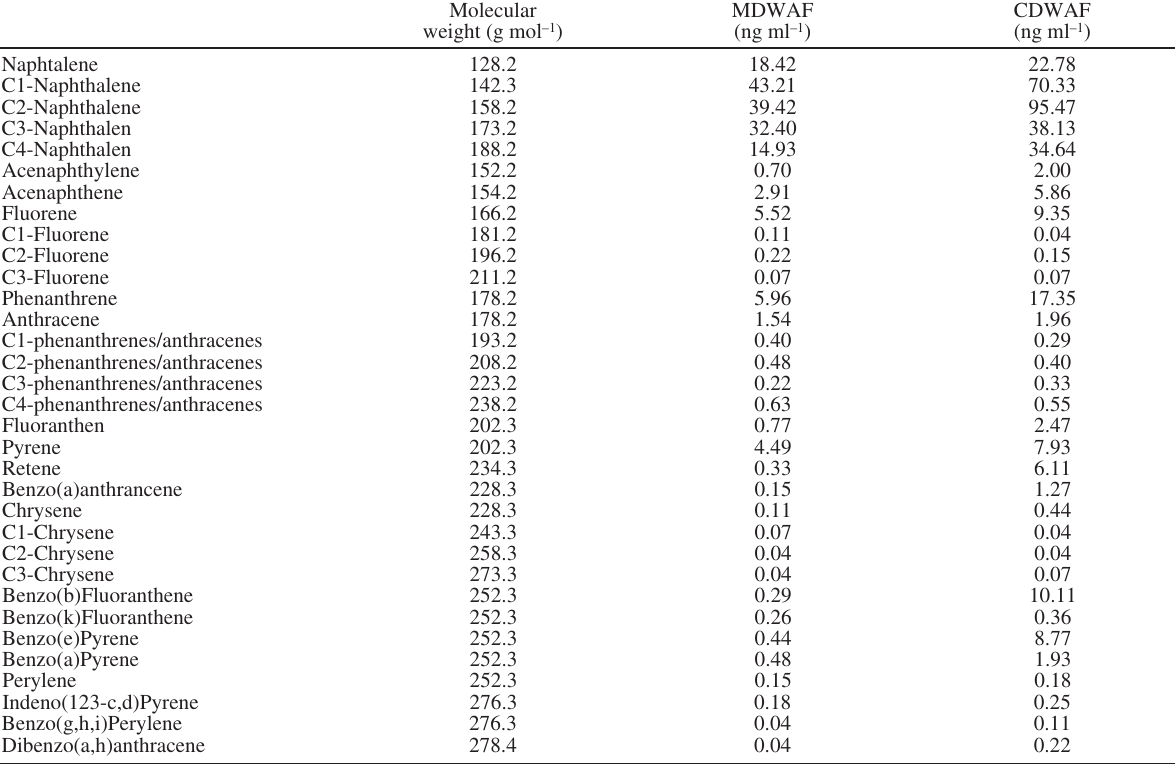
Table 1. – Concentration of 19 PAHs (alkylated and parents) in the MDWAF (5:1000) and CDWAF (5:1000) of No. 120 fuel oil. The 19 PAHs represents the 16 US-EPA PAHs and three supplementary PAHs (retene, benzo(e)pyrene and